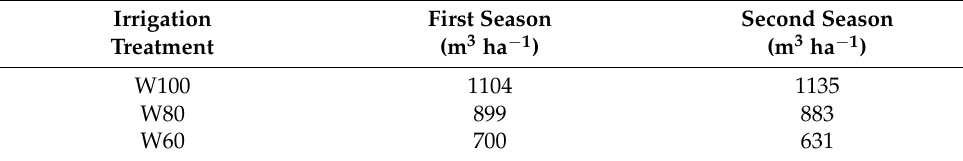
Table 2. Amount of water restitution during each cultivation cycle for the three treatments: W100 = 100% of water restitution; W80 = 80% of water restitution with respect to the standard (W100); W60 = 60% of water restitution with respect to the standard